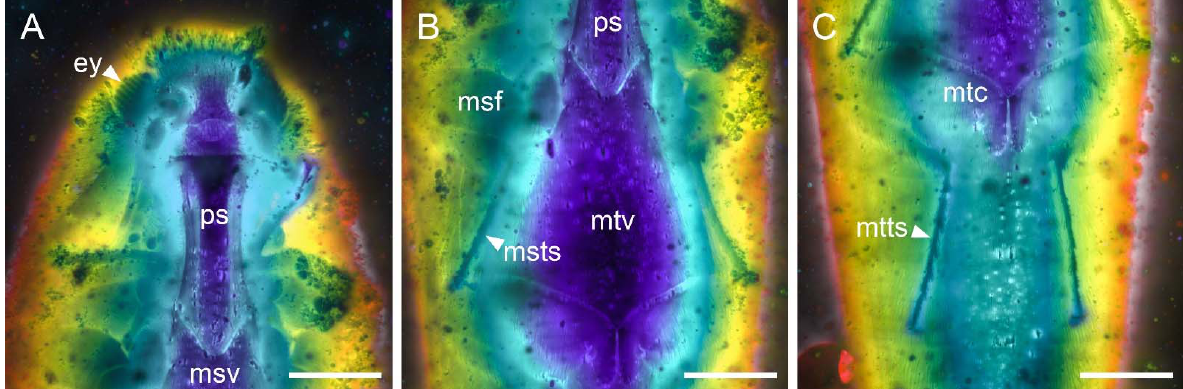
Figure 6. Details of Electrothroscus yanpingae gen. et sp. nov. , holotype, NIGP173916, under confocal microscopy, with depth colour coding. ( A ) Head and prothorax, ventral view. ( B ) Middle legs and metaventrite, ventral view. ( C ) Hind legs and abdomen, ventral view. Abbreviations: ey, compound eye; msf, mesofemur; msts, mesotarsus; msv, mesoventrite; mtc, metacoxa; mtts, metatarsus; mtv, metaventrite; ps, prosternum. Scale bars: 200 µ